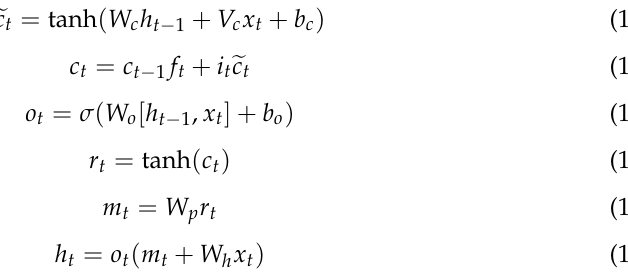
Figure 5. The codec is usually a multi-layer RNN or LSTM structure, where the interme- diate vector C contains x 1 , x 2 , …, x m encoding information. For time t, the output y t − 1 at the previous time, the hidden layer states s t − 1 and c at the previous time are input to the de- coder as inputs. Finally, the hidden layer state s t of the decoder is obtained, thereby pre- dicting the output value.